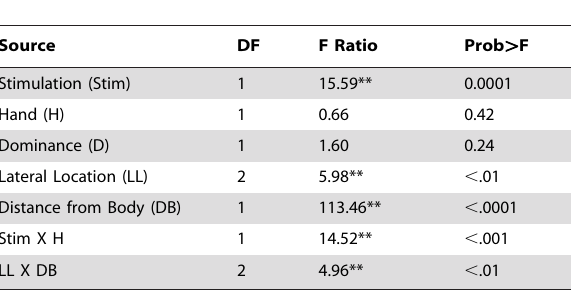
Table 6. Analysis of Variance for the uniformity of the accuracy across the workspace.